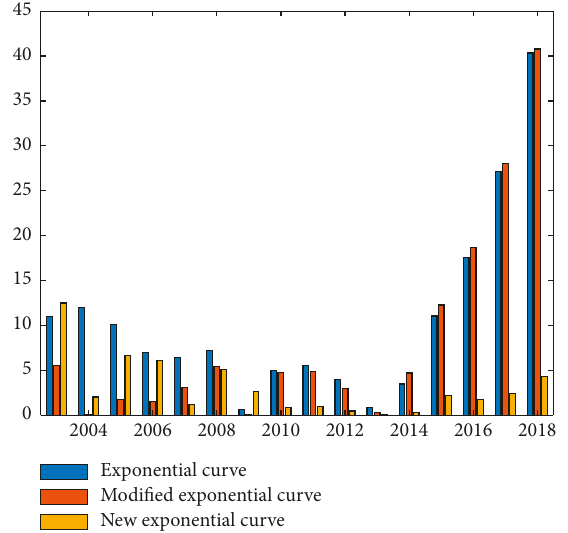
Figure 2: Absolute percentage error of private car ownership data by exponential curve, modified exponential curve, and new ex- ponential curve with first-order polynomial